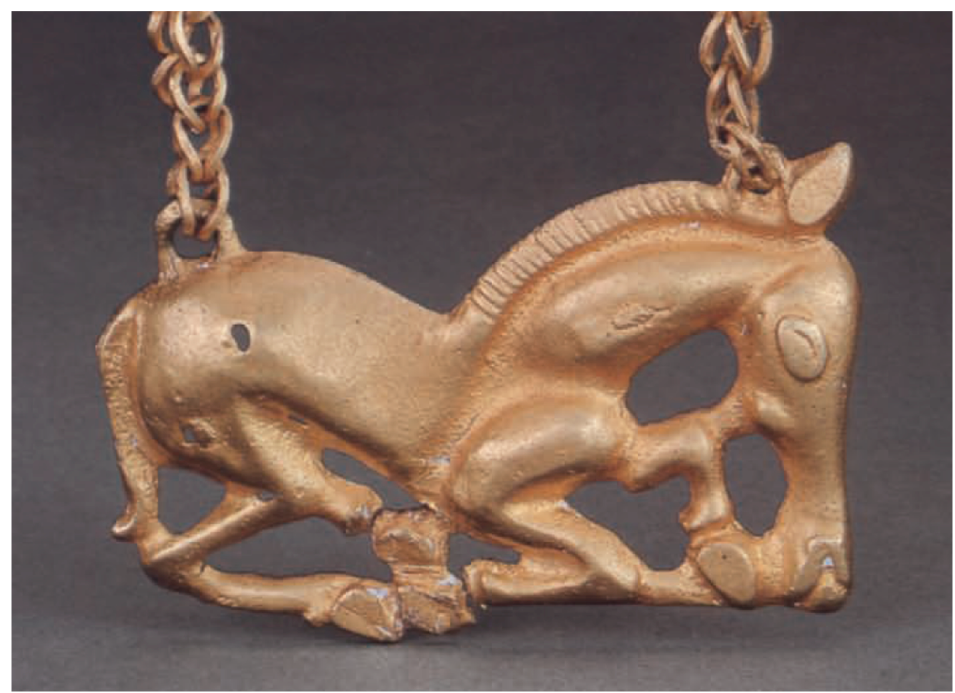
Figure 6. Plaque of a crouching horse, gold, excavated from Liujiazi, Horqin Left Middle Banner, Inner Mongolia. Late second–third century; after (Watt et al. 2004, p. 127).